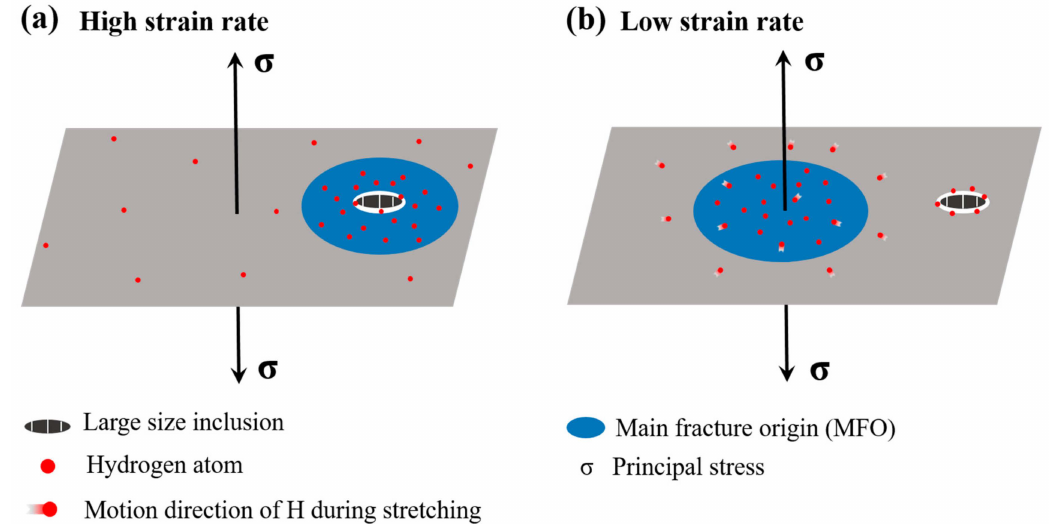
Figure 15. Schematic diagram of the fracture mechanism with di ff erent characteristics under a ( a ) high and ( b ) low strain rate of a pre-charged